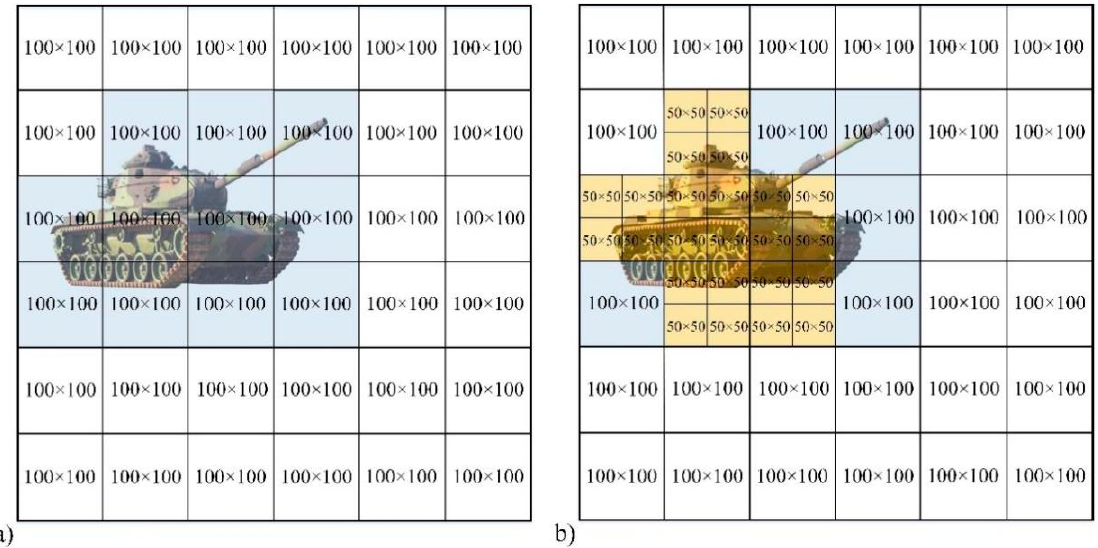
Figure 6. Comparison of original (a) and proposed (b) methods. Figure 6b is the method to obtain the reconstructed image based on the threshold. It